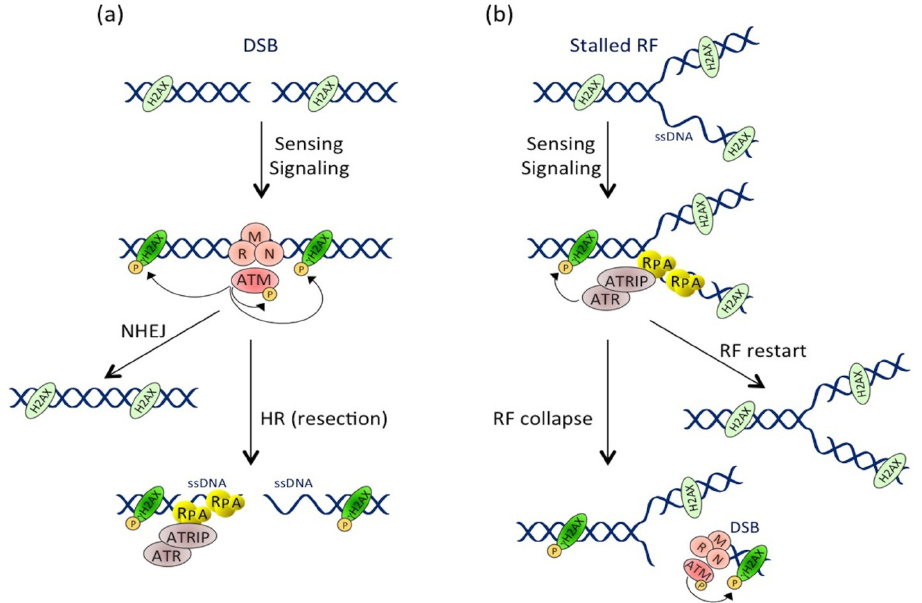
Figure 2. Activation and crosstalk between the ATM and ATR pathways. ( a ) Pathway activation at the double-stranded break (DSB). DSB formation induces the MRN-dependent ATM recruitment. ATM then phosphorylates numerous substrates, including itself and H2AX near the DSB site. DSB repair occurs through non-homologous end joining (NHEJ) or homologous recombination (HR) mechanisms (see Section 3.2 for details). During HR, resection of the DSB extremities produces ssDNA stretches that are coated by RPA, leading to ATRIP-dependent ATR recruitment and activation. ( b ) Pathway activation during replicative stress. Replication fork (RF) stalling induces ssDNA formation that is rapidly coated by RPA. This structure is recognized by ATRIP, which drives the recruitment and activation of ATR. Besides phosphorylating its other substrates, ATR locally phosphorylates H2AX. RF can restart in case of transient stress or collapse after prolonged stresses. RF collapse induces DSB formation and ATM pathway activation, leading to a second and more important wave of H2AX